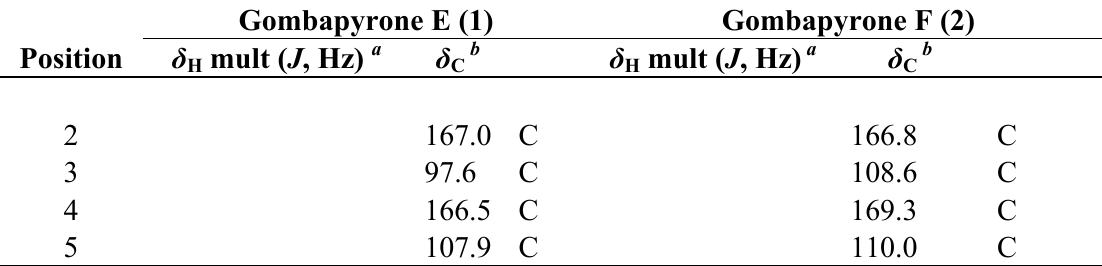
Table 1. 1 H and 13 C-NMR spectral data for gombapyrone E ( 1 ) and F ( 2 ) in methanol- d